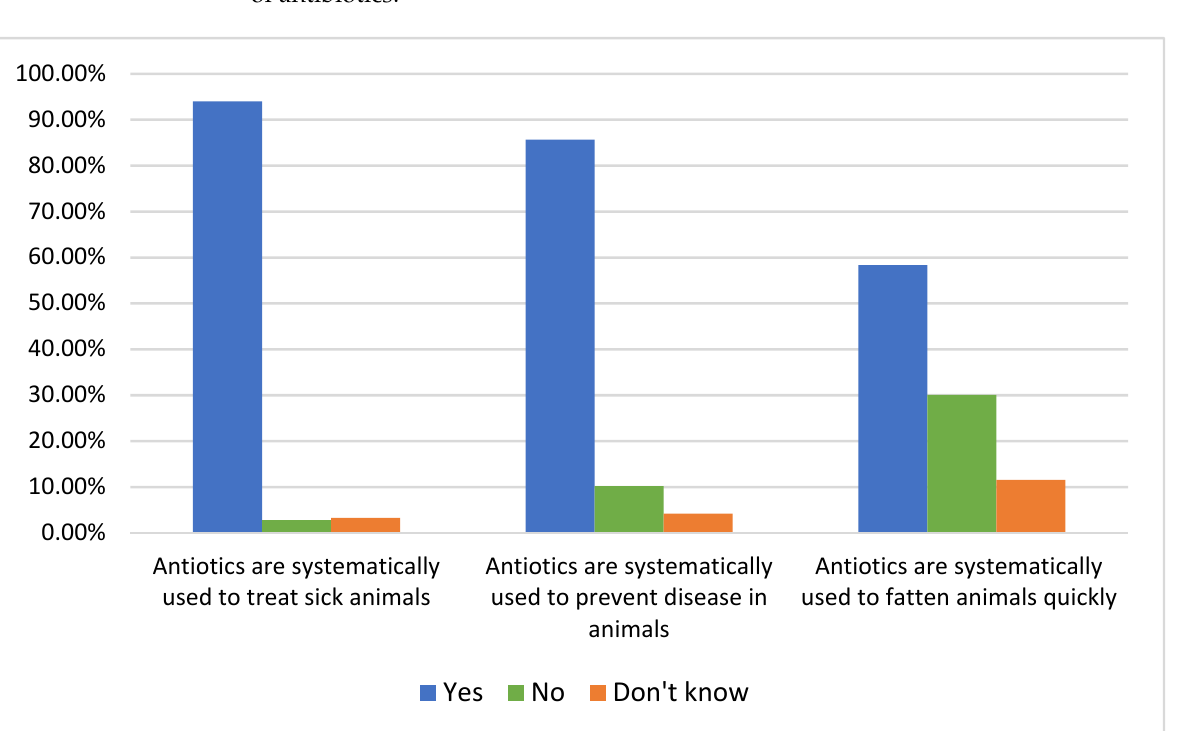
Table 3. Biosecurity practices and attitudes encountered on the farms.